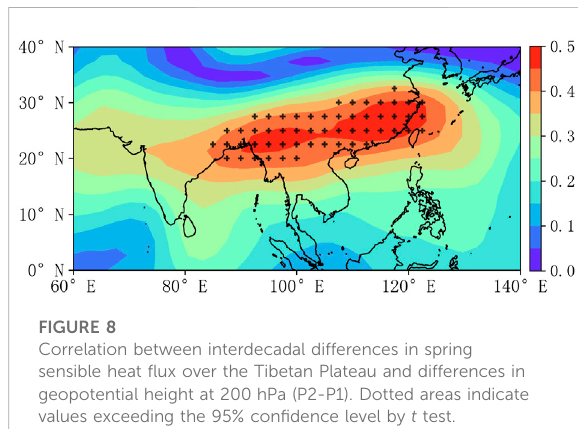
FIGURE 8 Correlation between interdecadal differences in spring sensible heat fl ux over the Tibetan Plateau and differences in geopotential height at 200 hPa (P2-P1). Dotted areas indicate values exceeding the 95% con fi dence level by t